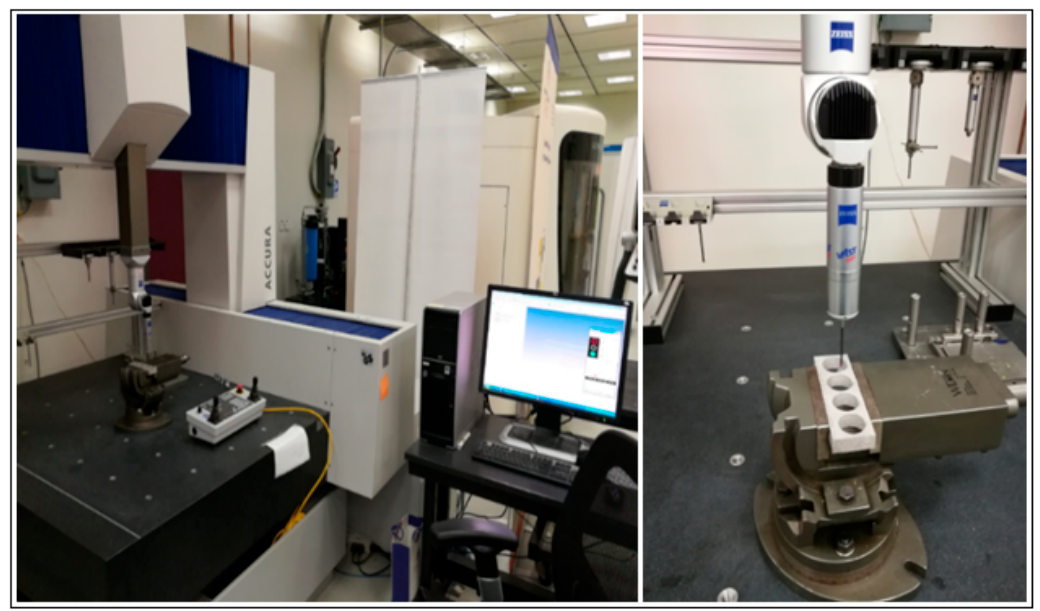
Figure 7. ( a ) The build with sintered powder; ( b ) Powder recovery system.